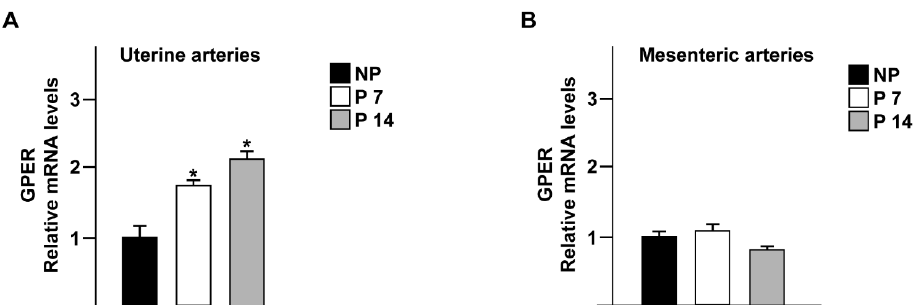
Figure 1. Pregnancy increases GPER expression in uterine but not in mesenteric arteries. GPER expression was quantified by qPCR in uterine ( A ) and mesenteric ( B ) arteries from non-pregnant (NP) and pregnant rats at 7 (P7) and 14 (P14) days of gestation. GPER mRNA was significantly higher in uterine arteries from both P7 and P14 rats compared with NP rats ( A ). Expression levels were not affected by pregnancy in mesenteric arteries ( B ). * p < 0.05, P7, P14 vs. NP, by one-way ANOVA. n = 3 independent experiments per group performed in triplicate.